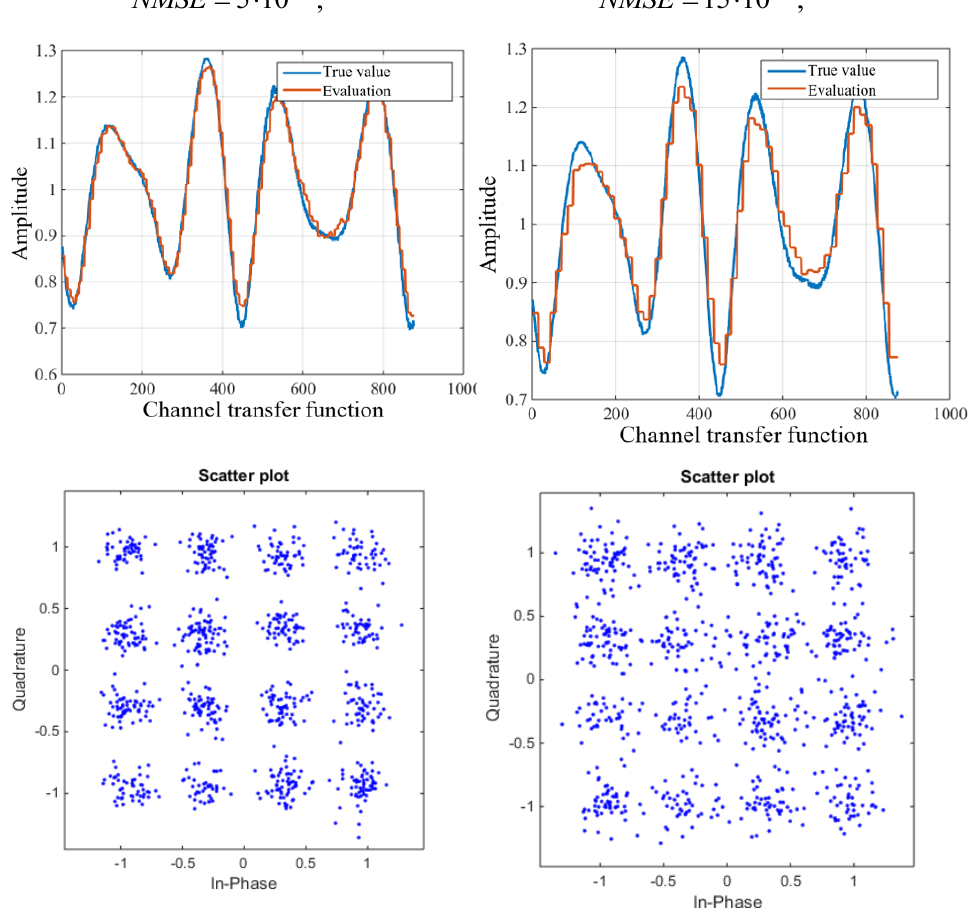
Fig. 4. Transfer function and signal constellations at different values of the normalized RMS error of the estimation of the transfer